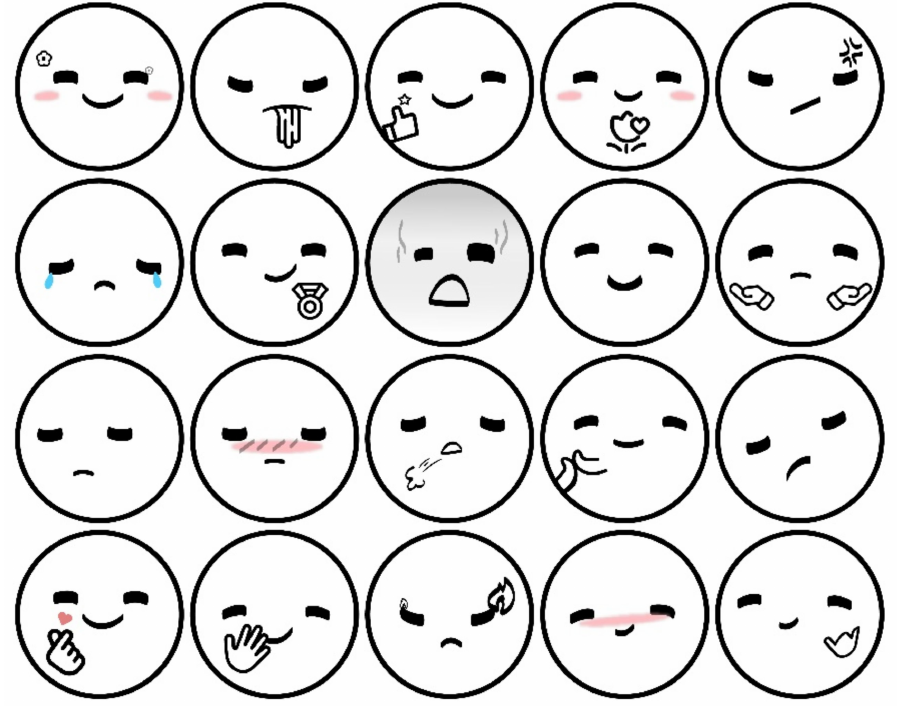
Figure 2. 20 emotions of expression design. The emotions are, from left to right, top to bottom: happy-for, hate, satisfaction, gratitude, reproach, distress, pride, fear, mildness, pity, boredom, shame, disappointment, hope, resentment, love, gloating, anger, relief and